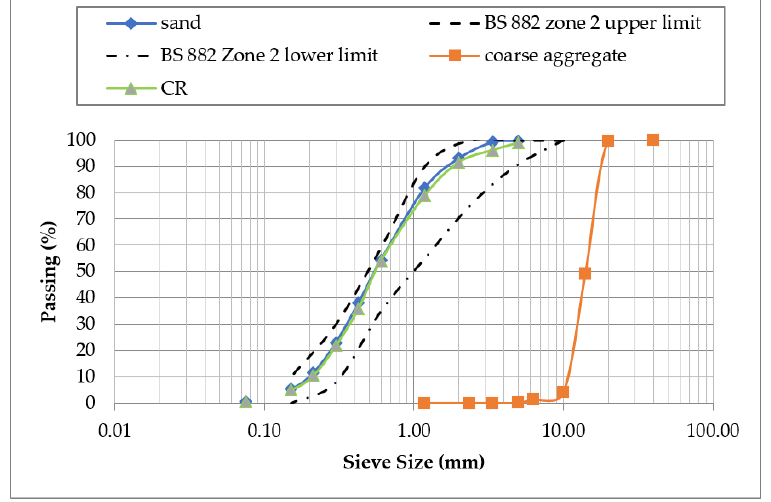
Figure 1. Particle size distribution of coarse aggregate.